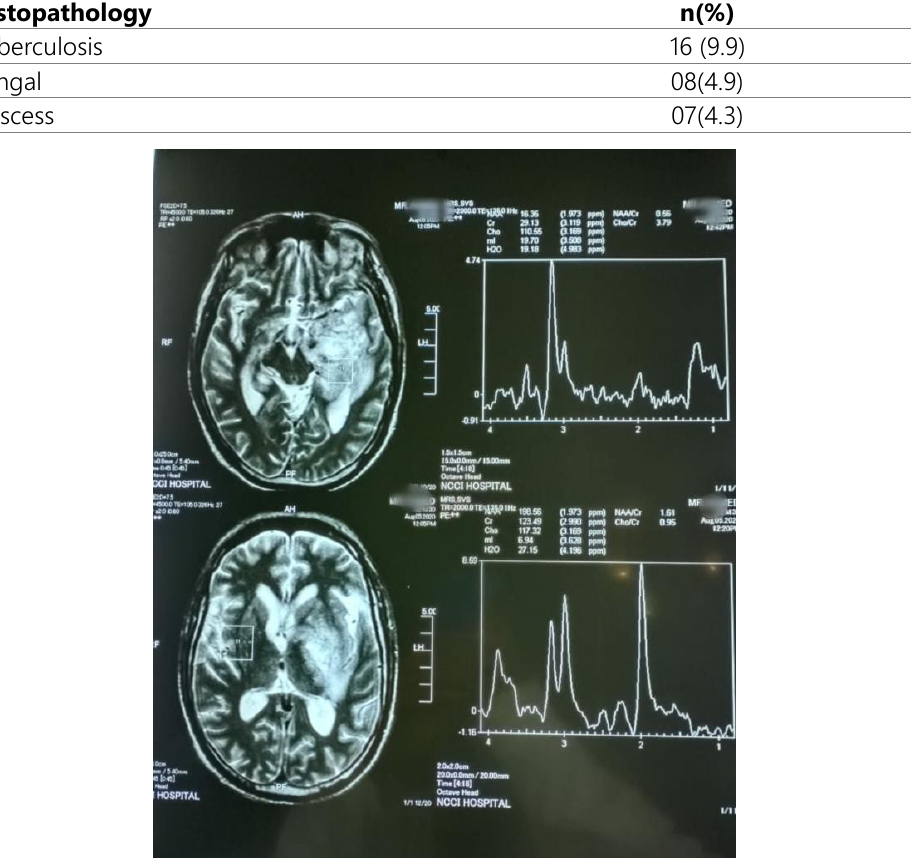
Table 5: Non-neoplastic infectious pathology based on histopathology